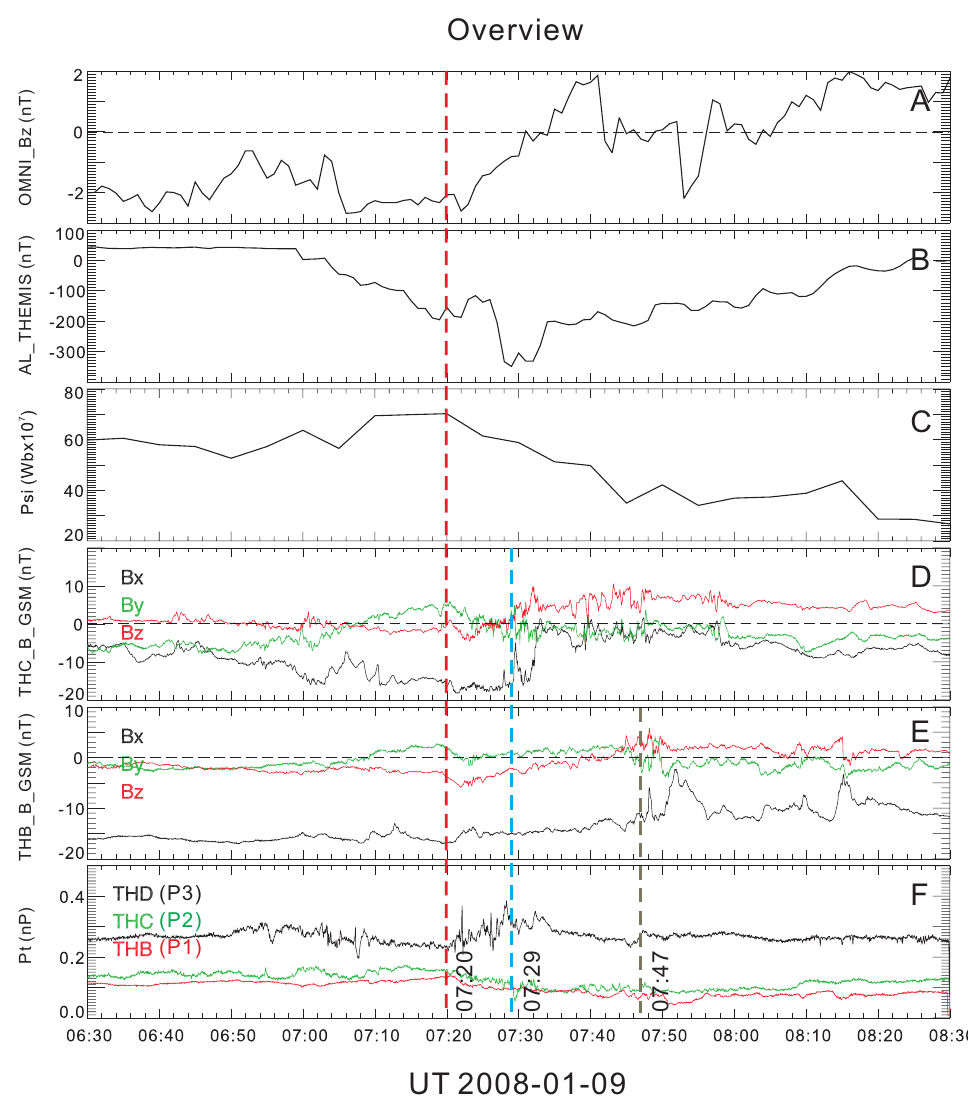
Fig. 2. Overview of the 9 January 2008 event: from top to bottom is B z component of IMF at 1AU, THEMIS AL index, polar cap open flux psi, magnetic field at THC (P2), magnetic field at THB (P1) and total pressure. The red vertical dashed line stands for the start time of lobe reconnection, whereas the cyan and black vertical dashed line mark the time when THC (P2) and THB (P1) encountered the earthward side reconnection separatrices,